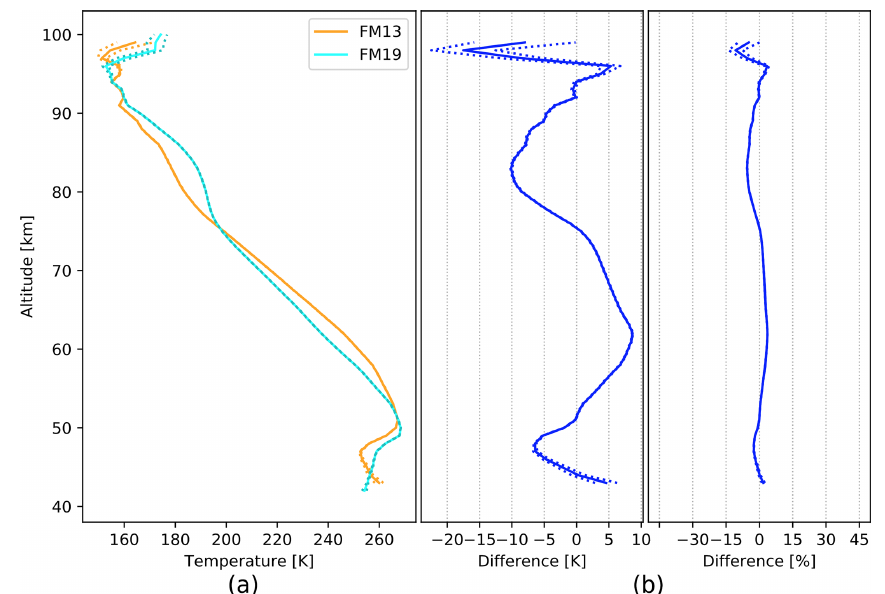
Figure A4. Absolute differences (a) and relative differences (b) between SMR v3.0 FM13 and FM19 temperatures. The data plotted are global averages over the whole time period between February 2001 and April